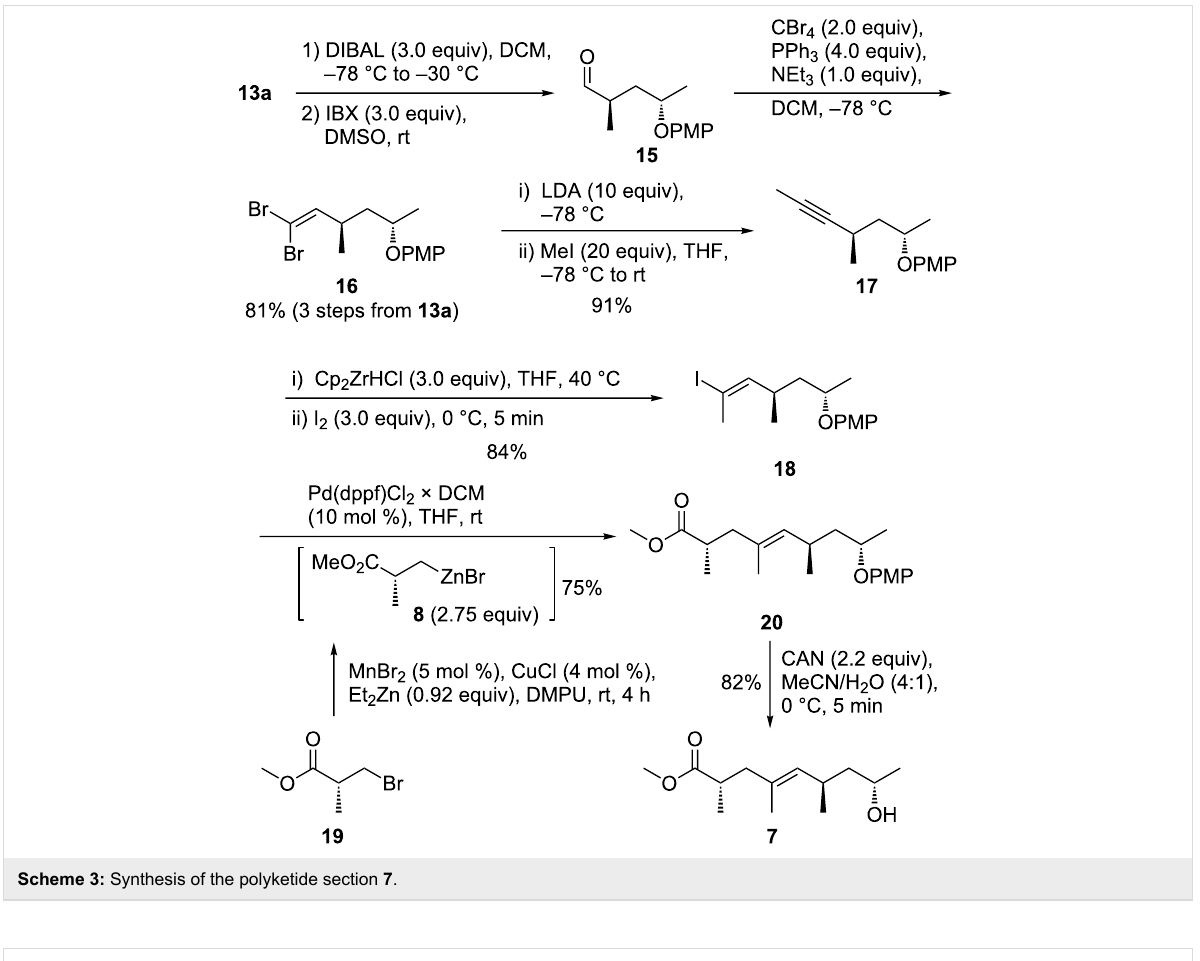
Scheme 3: Synthesis of the polyketide section 7 .